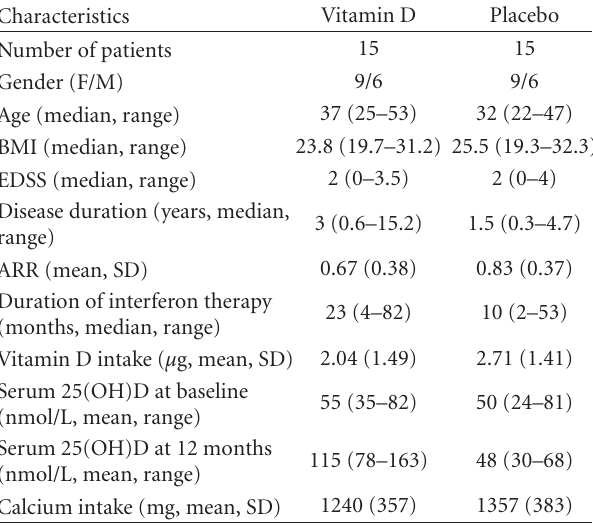
Table 1: Patient characteristics and serum 25(OH)D levels in the vitamin D-and placebo-treated active subgroup